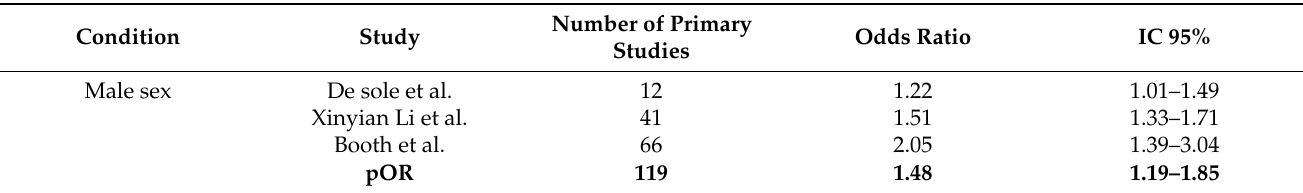
Table 2. Meta-analysis of the different patients’ characteristics and underlying conditions and the risk of hospitalization due to